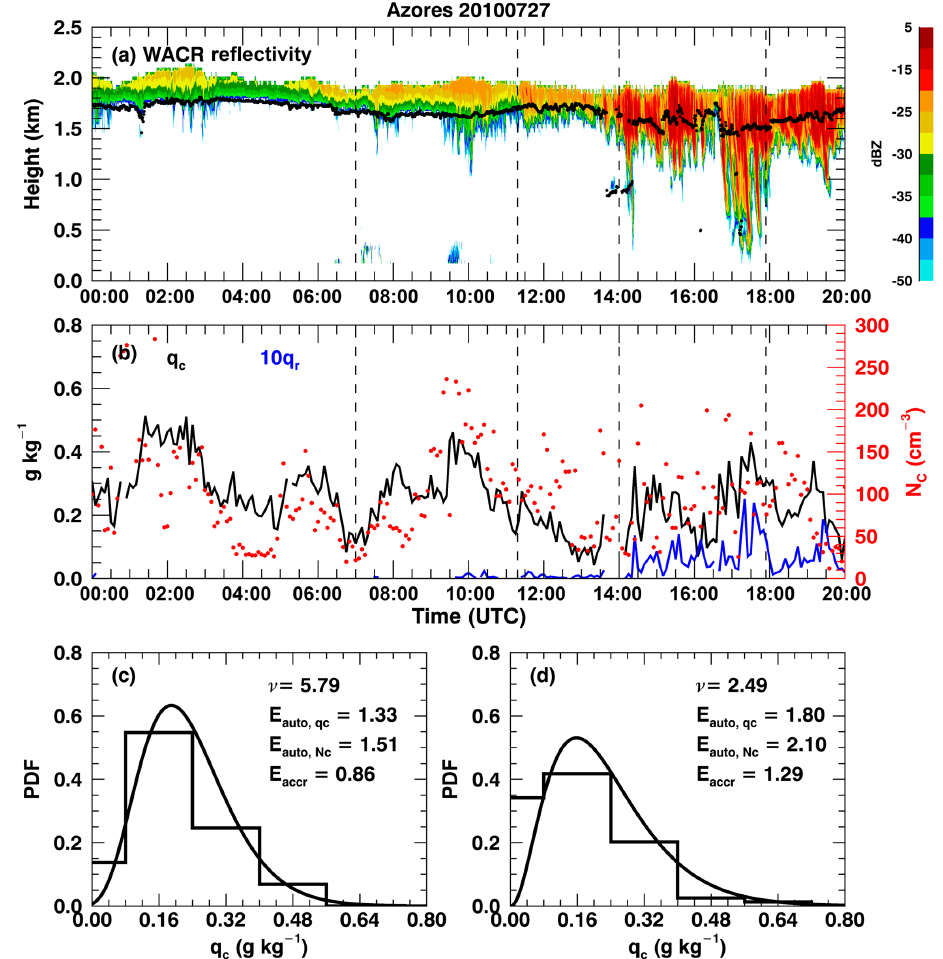
Figure 1. Observations and retrievals over the Azores on 27 July 2010. (a) W-band ARM cloud radar (WACR) reflectivity (contour) super- imposed with cloud-base height (black dots). (b) The black line represents averaged cloud water mixing ratio ( q c ) within the top five range gates, the blue line represents averaged rain ( × 10) water mixing ratio within five range gates around maximum reflectivity, and red dots are the retrieved cloud droplet number concentration ( N c ) . Dashed lines represent two periods that have 60km equivalent sizes with similar q c but different distributions as shown by step lines in panels (c) and (d) . Curved lines in panels (c) and (d) are fitted gamma distributions with the corresponding shape parameter ( ν) shown on the upper right. N c distributions are not shown. The calculated autoconversion ( E auto, qc from q c and E auto , N from N c ) and accretion ( E accr ) enhancement factors are also c